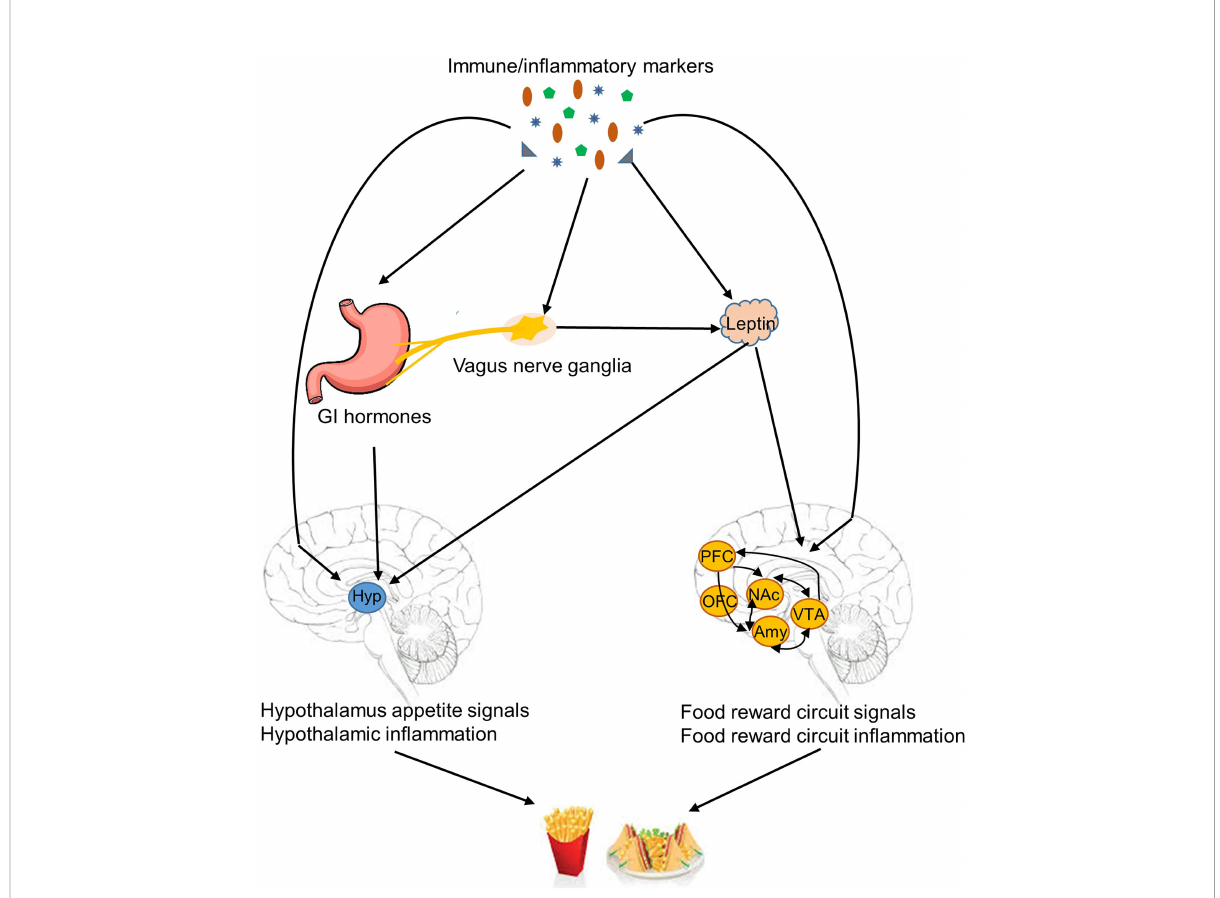
FIGURE 2 Mechanisms linked immune/in fl ammatory markers to obesity-related eating behaviors. Immune/in fl ammatory markers are potentially involved in several mechanisms of regulation of obesity-related eating behaviors, including modulation of orexigenic and anorexigenic signals in the hypothalamus, induction of hypothalamic in fl ammation, regulation of food reward circuitries, and suppression anorexigenic signals by induction of in fl ammation in the vagus nerve ganglia. GI, gastrointestinal tract; Hyp, hypothalamus; PFC, prefrontal cortex; OFC, orbitofrontal cortex; NAc, nucleus accumbens; Amy, amygdala; VTA, ventral tegmental